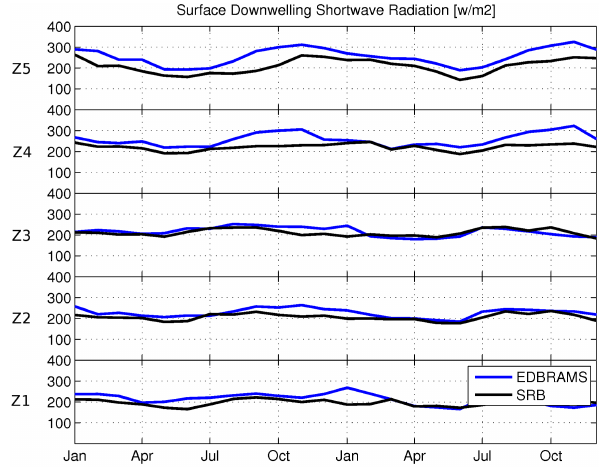
Figure D2. Mean monthly surface radiation from ED2-BRAMS and the Surface Radiation Budget (SRB) product version 2.5, years 2002–2003. Spatial means are taken within zones according to Fig.